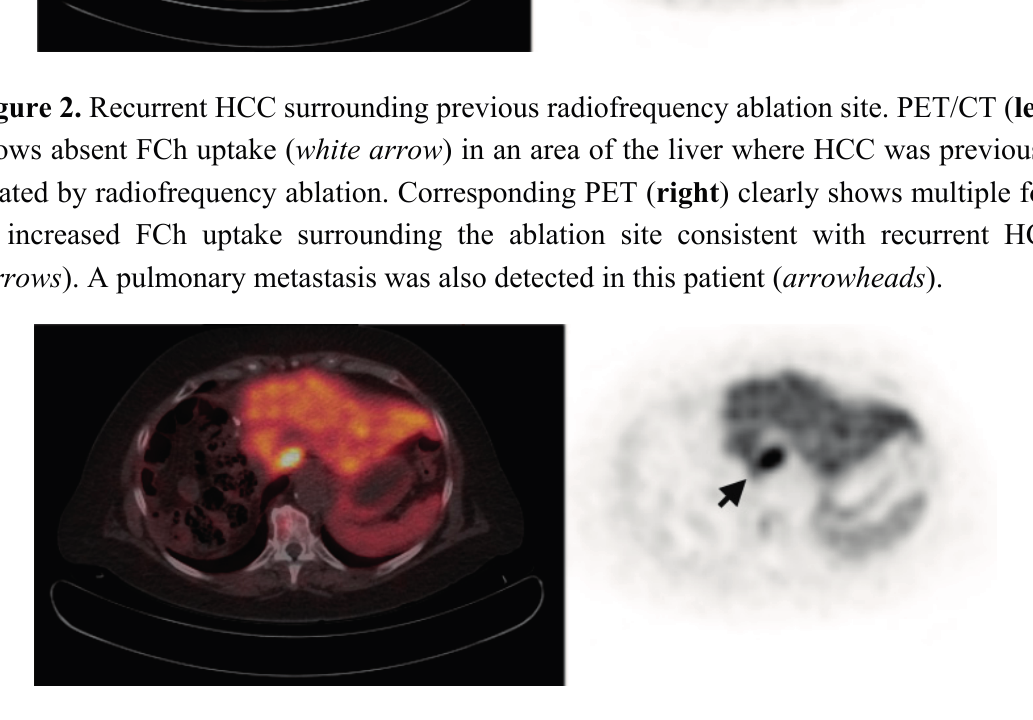
Figure 3. Tumor recurrence near a resection margin. Corresponding PET/CT ( left ) and PET ( right ) images of the remnant liver status post partial right hepatectomy shows focal increased FCh uptake ( arrow ) adjacent to the resection margin. Histology confirmed this lesion as recurrent